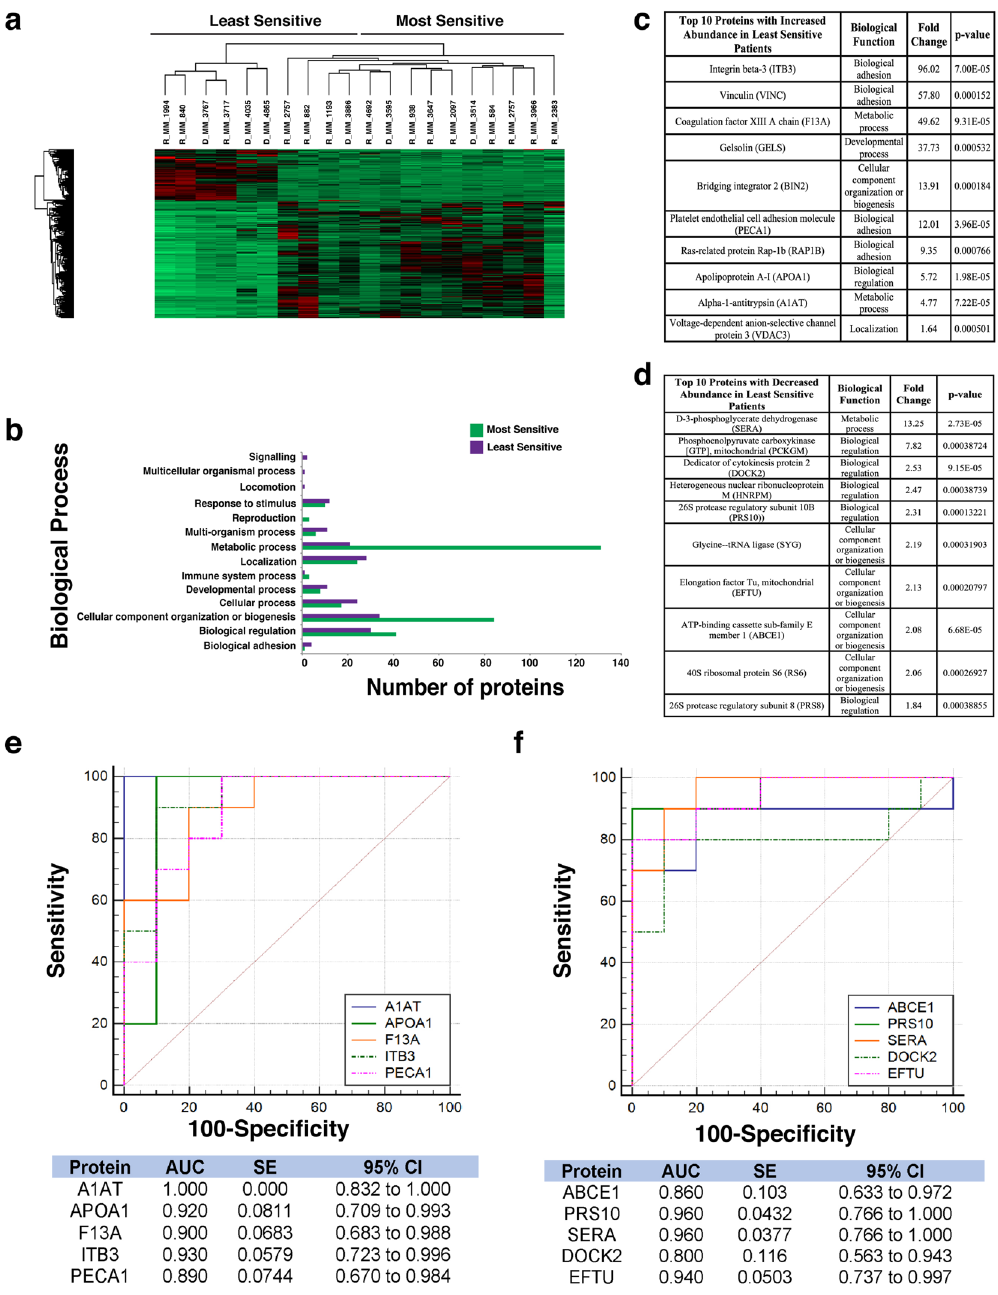
Figure 4. Proteomic analysis of patients following PF-04691502 treatment. ( a ) Heatmap showing protein abundance changes of patients most and least sensitive to PF-04691502. Red indicates an increase in protein abundance, while green a decrease in protein abundance. ( b ) Graph showing the biological processes associated with the most and least sensitive patients. ( c ) List of the top ten proteins with increased abundance in the least sensitive patients. The associated biological function, fold change and p-value are also shown. Proteins were designated by p-value and arranged hierarchically by fold change. ( d ) List of the top ten proteins with decreased abundance in the least sensitive patients. The associated biological function, fold change and p-value are also shown. Proteins were designated by p-value and arranged hierarchically by fold change. ( e ) ROC analysis for top five statistically significant proteins with an increased abundance for the least sensitive patients to PF-04691502, including the calculated AUC, standard error (SE) and 95% confidence interval (CI). ( f ) ROC analysis for the top five statistically significant proteins with a decreased abundance for the least sensitive patients to PF-04691502, including the calculated AUC, standard error (SE) and 95% confidence interval